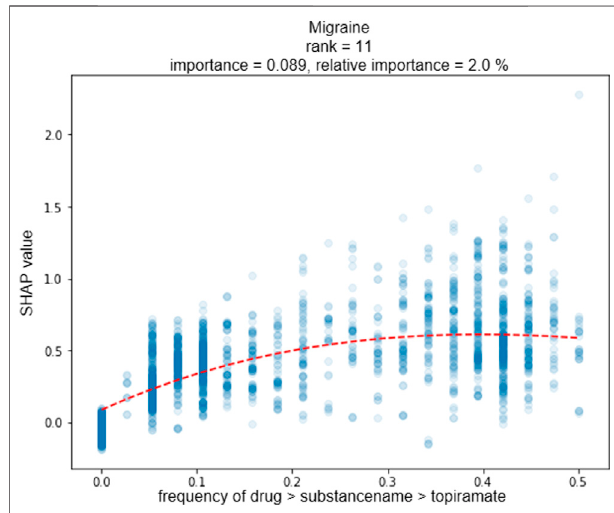
FIGURE 9 | Plot shows the marginal dependency of the frequency of topiramate prescription on the predicted risk on later migraine diagnosis. One dot represents one patient; x -axis: prescription frequency (0% (cid:1) never observed, 100% (cid:1) observed every month of a patient ‘ s medical history); y -axis: change in SHAP value ( (cid:1) change in individual hazard rate). Marginal dependency plots for each comorbidity for the top 5 features can be found in the Supplemental Material ( Supplementary Figures S7 – S12